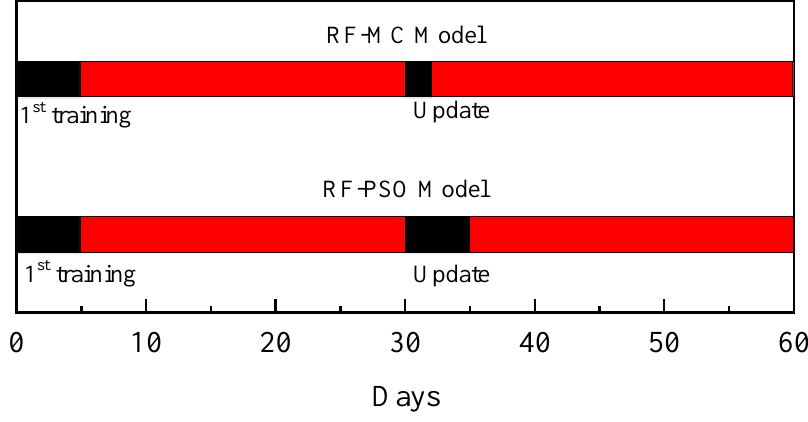
Figure 8. Application comparison of RF-PSO model and RF-MC model.